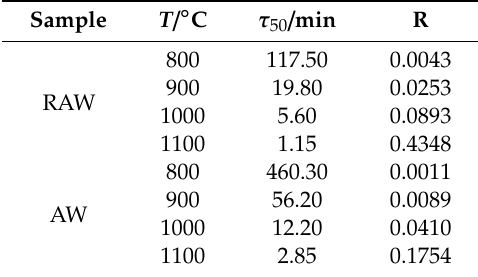
Table 1. E ff ects of temperature on gasification characteristic